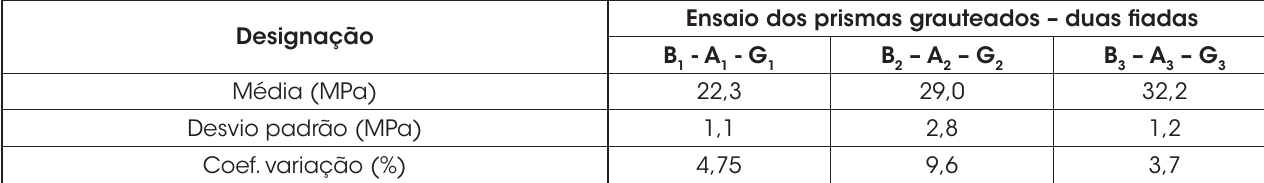
Resumo das tensões de compressão máxima calculada para os prismas grauteados